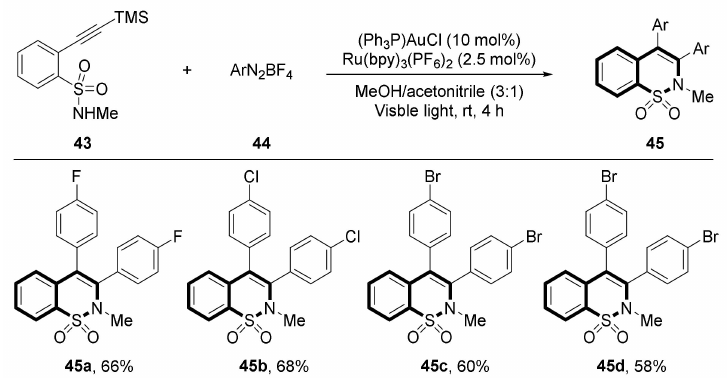
Scheme 17. Dual photoredox and gold catalysis for benzosultams